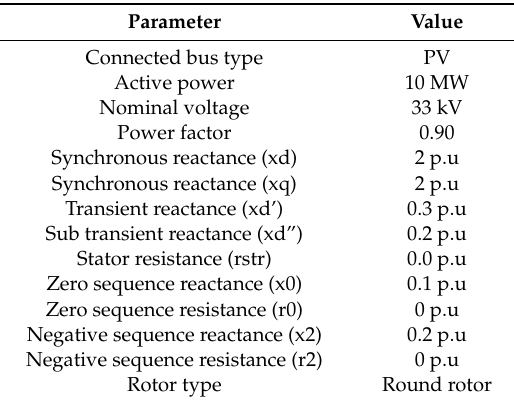
Figure 2. Schematic view of modified 14 bus microgrid. Table 3. System generator parameters.